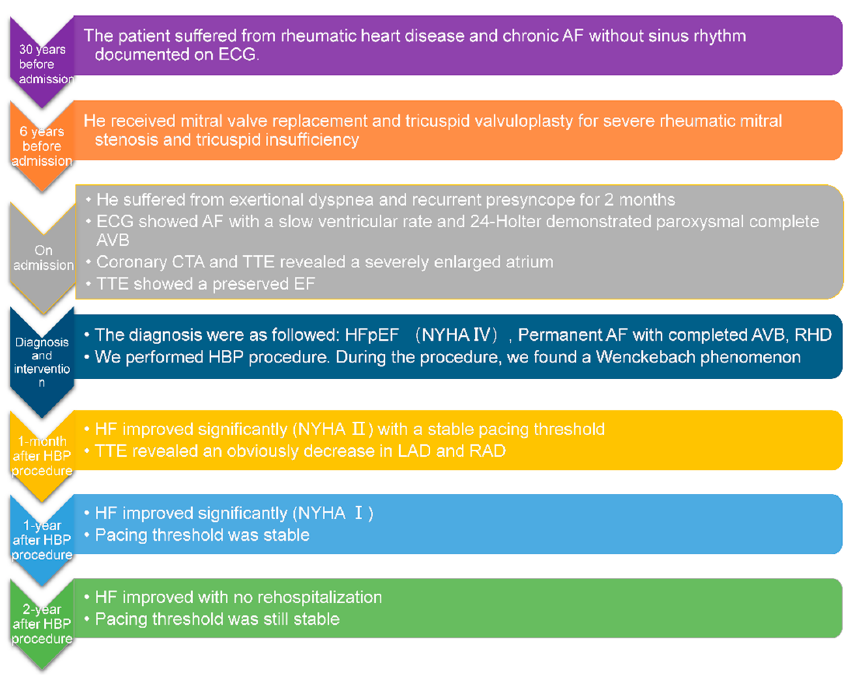
( C ) shows changes in cardiac remodeling. LVD: left ventricular diameter; LAD: left atrial diameter; RALRD: right atrial left-right diameter; RAAPD: right atrial anteroposterior diameter; EF: ejection fraction; NYHA: New York Heart Association.